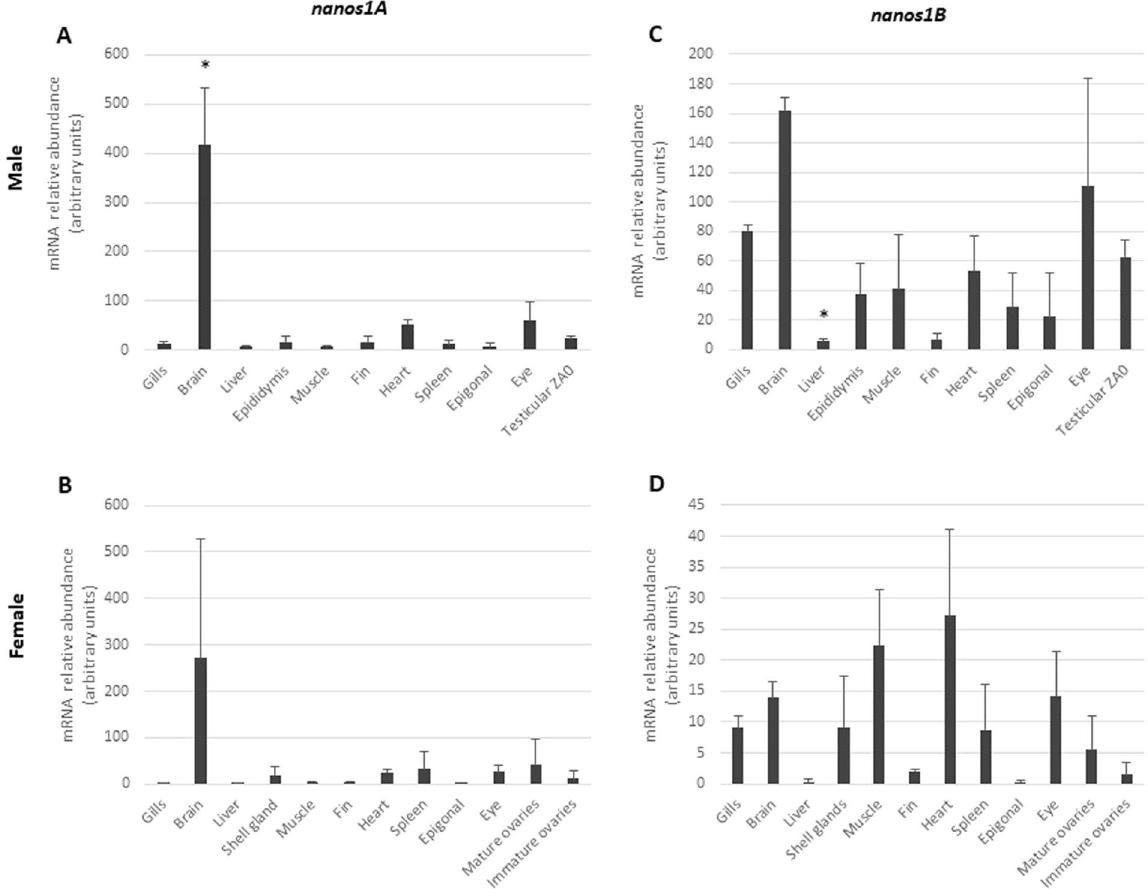
Figure 3. nanos1A and na nos1B transcripts show distinct tissue distributions in male and female S. canicula . Messenger RNA relative abundances of nanos1A ( A , B ) and nanos1B ( C , D ) were quantified in panels of tissues in male ( A , C ) and female (B , D ) dogfish by real-time PCR. Data were normalized using 5S rRNA . In both sexes, nanos1A showed a preferential expression in brain ( A , B ) whereas nanos1B showed a relatively ubiquitous expression pattern ( C , D ). Mature ovaries sampled from adult females and containing vitellogenic oocytes showed no significant difference of expression levels compared to immature ovaries sampled from pre-adult females and containing previtellogenic oocytes only ( B , D ). Data are presented as mean + SD (N = 3). Differences in gene expression were evaluated using one-way analysis of variance followed up with Games- Howell test. Significant differences (p ≤ 0.05) in gene expression compared to the testicular zone A0 or the immature ovary are indicated by asterisks ( *